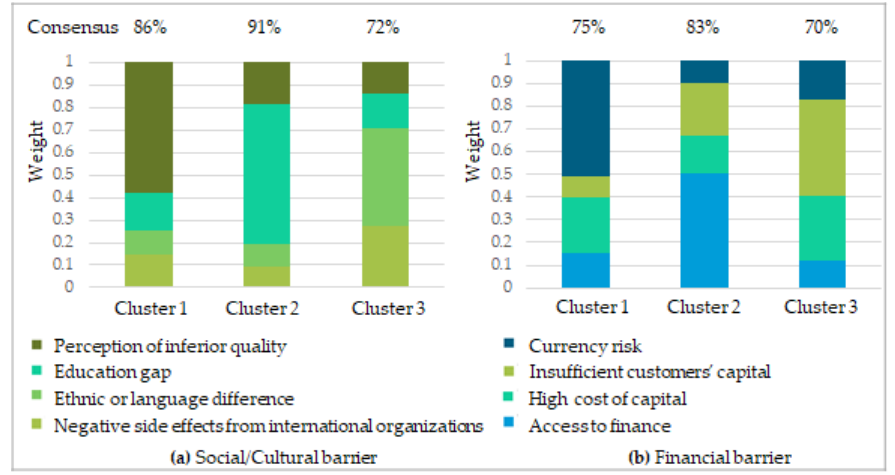
Figure 3. Averaged weights of clustered results.